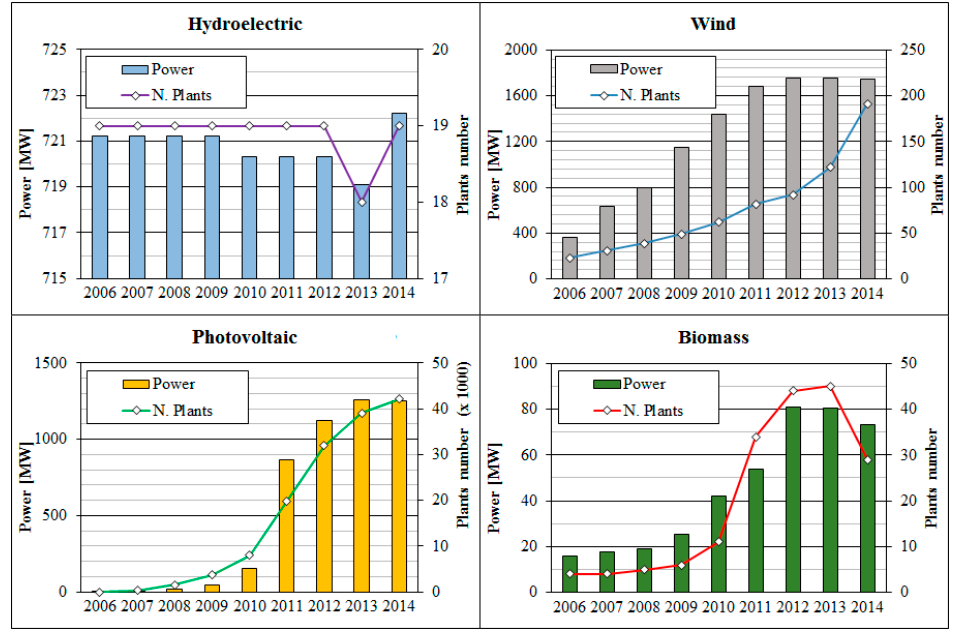
Figure 3. Installed power and plants number from renewable sources (hydroelectric, wind, photovoltaic, and biomass) in decade 2004–2014.